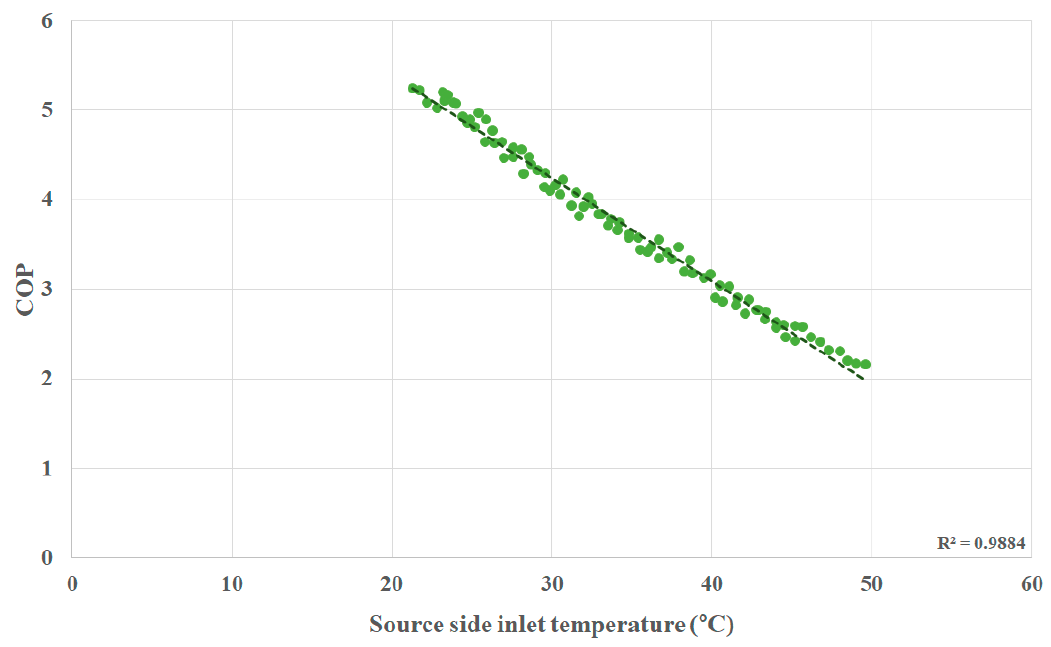
Figure 8. Performance according to load-side inlet temperature during cooling operating.